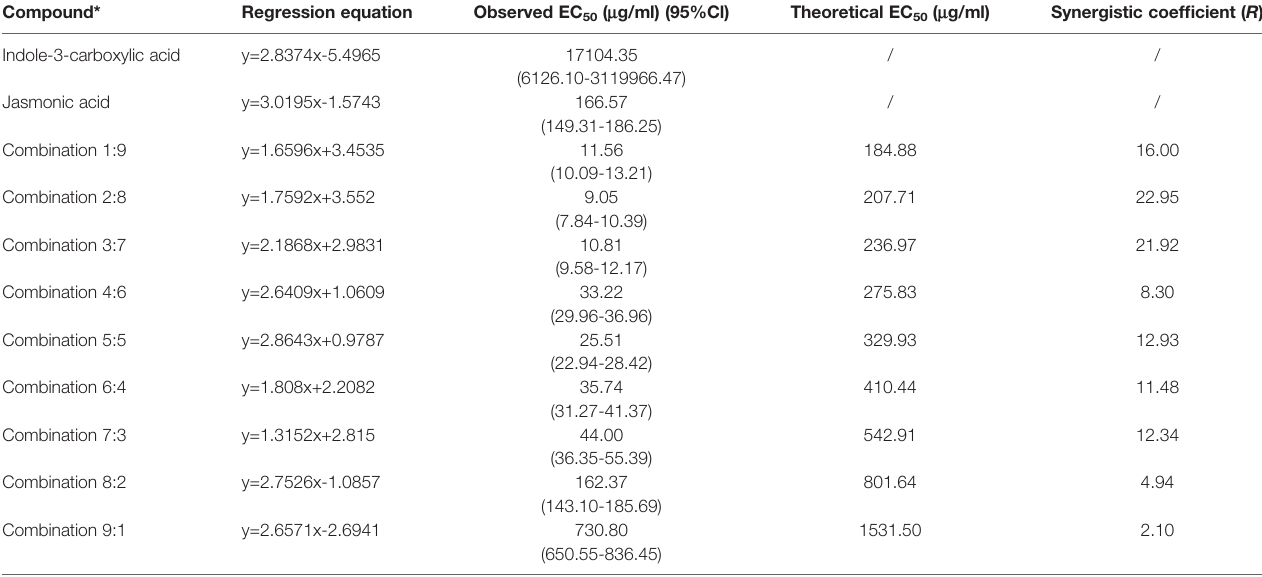
TABLE 3 | The activities of indole-3-carboxylic acid, jasmonic acid, and their combinations on wheat powdery mildew in the